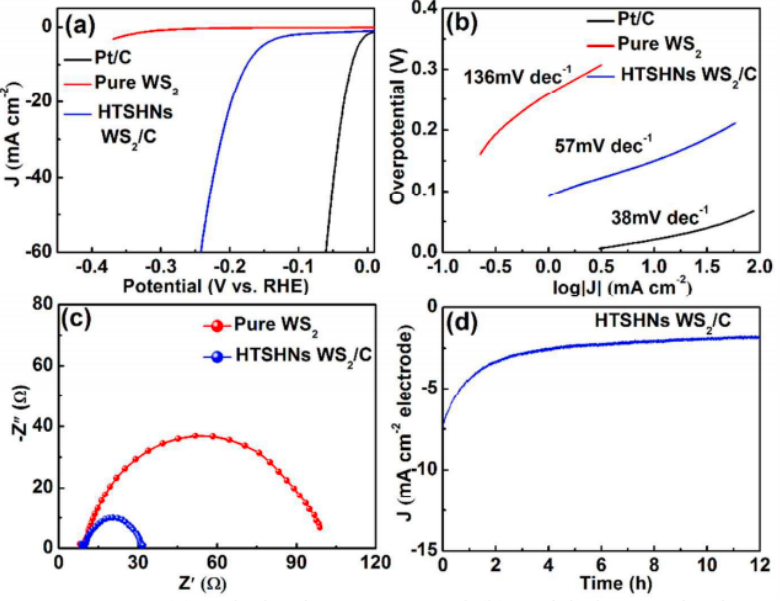
Figure 13. HER performance: ( a ) LSV curves and ( b ) Tafel plots of pristine WS 2 , WS 2 /C heterostructure and Pt/C. ( c ) EIS measurements for pure WS 2 and WS 2 /C heterostructure. ( d ) The chronoamperometry of WS 2 /C at − 0.2V. Reproduced with permission. [148] Copyright 2018, RCS.